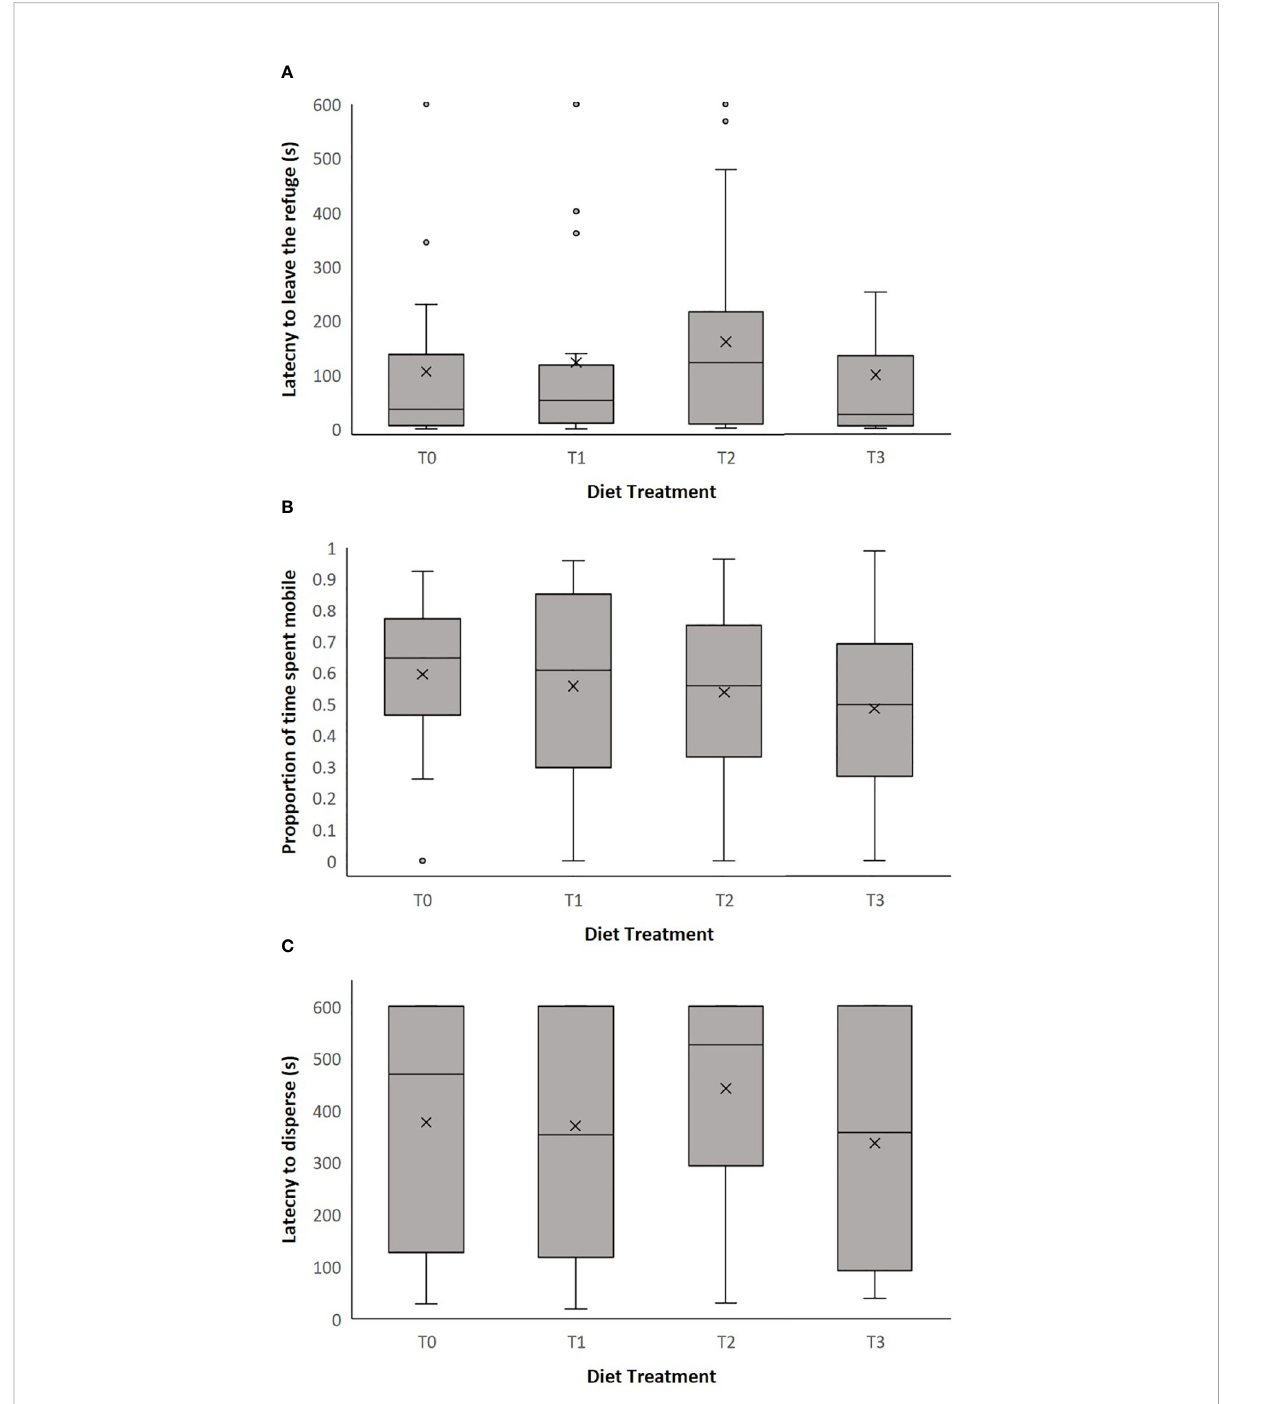
FIGURE 2 The effect of diet treatment (T0, T1, T2 and T3) on (A) latency to leave the refuge (seconds), (B) proportion of time spent mobile in release apparatus and (C) latency to disperse into fi eld enclosure (seconds) in adult P. corroboree . The box plots show the median, 25 th and 75 th percentiles, the whiskers indicate values within 1.5 times the interquartile range. The cross represents the mean value and the circles are outliers. Data shown are untransformed. Diet treatments were: T0 (0mg/g b -carotene, n = 30), T1 (1mg/g b -carotene n = 31), T2 (2mg/g b - carotene n = 28) and T3 (3mg/g b -carotene, n =